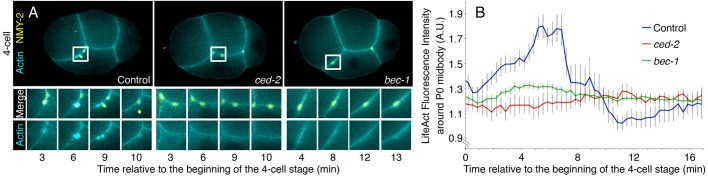
PI3K acts during phagocytosis to internalize the midbody. (A) In control BV113 embryos (left, n=13 embryos), actin accumulates around the P0 midbody before internalization. Actin does not accumulate in ced-2 (n=11) or bec-1 (n=5) mutants. NMY-2::GFP labels midbodies (yellow) and LifeAct::RFP labels F-actin (cyan). See also Fig. S2 and Movies 2–4. (B) LifeAct::RFP fluorescence intensity is significantly reduced around the P0 midbody in ced-2 (red) and bec-1 (green) mutants compared to control embryos (blue) (P<0.01). In controls, internalization occurs 7±4 min (mean±s.d.) after the four-cell stage (n=14). Graphed results are mean±s.e.m. Student's t-test with Bonferroni correction was used for statistical analysis.